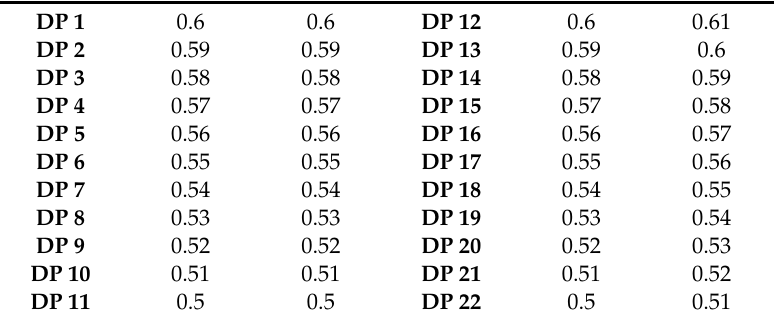
Table 10. Design points for the through-flow analysis.